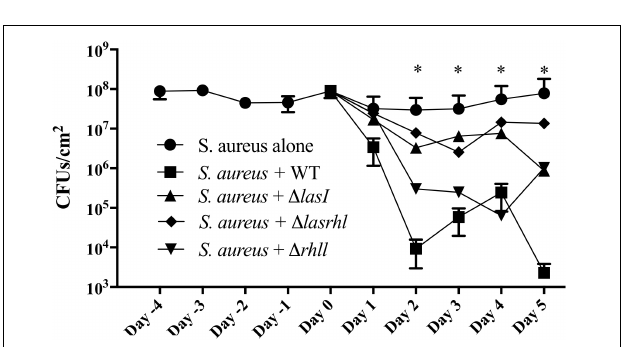
FIGURE 7 | Effect of quorum sensing inactivation on the presence of S. aureus when in co-culture with P. aeruginosa . Biofilms of S. aureus were allowed to establish for a period of 5 days in microtiter plates after which, P. aeruginosa was introduced at a 1:250 ratio. P. aeruginosa strains consisted of PAO1 WT, (cid:49) lasI , (cid:49) lasIrhl , and (cid:49) rhll . Upon introduction of P. aeruginosa , viability of dual-species biofilms was quantified for further 5 days. Biofilms were cultured in 10% BHI at 37 ◦ C under static conditions. Media was exchanged every 12 h. ∗ p < 0.001 all strains compared to S. aureus alone.